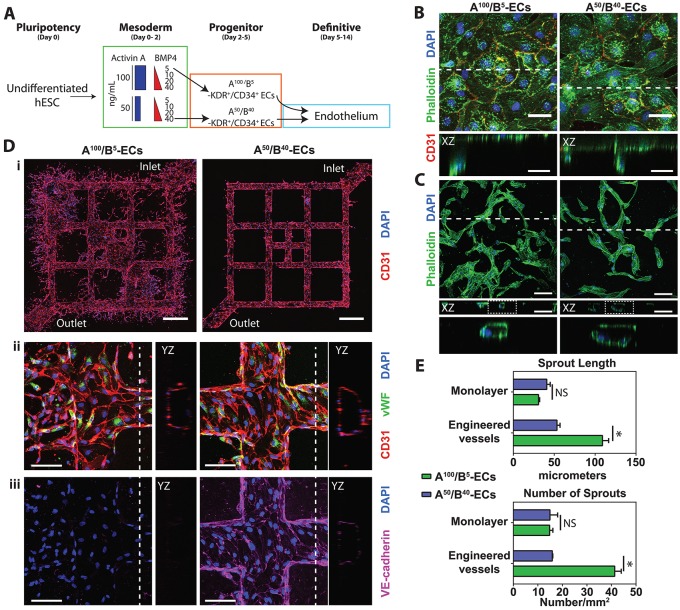
KDR+/CD34+ cells can differentiate into functional endothelium. (A) Experimental approach for directing undifferentiated hESCs into A100/B5 and A50/B40 ECs and then into differentiated and functional ECs. (B,C) Day 14 A100/B5 and A50/B40 ECs were plated onto collagen as a monolayer to assay sprouting angiogenic potential (B) or embedded into collagen to assay tube formation potential (C). Orthogonal views (at the dashed line) are shown beneath as a z-stack in the xz axis. (D) Day 14 A100/B5 and A50/B40 ECs were seeded into engineered microvessels (i) and exposed to flow for 4 days. Engineered microvessels were assayed for vessel structure and cellular expression of VWF and CD31 (ii) as well as VE-cadherin (iii) together with a nuclear counterstain. Orthogonal views are shown to the side as a z-stack of the yz axis. (E) Quantification of the number and length of sprouting vessels in monolayer and engineered vessels. n≥3 replicates per sample. *P<0.05; NS, not significant. Scale bars: 100 µm, except 500 µm in Di.